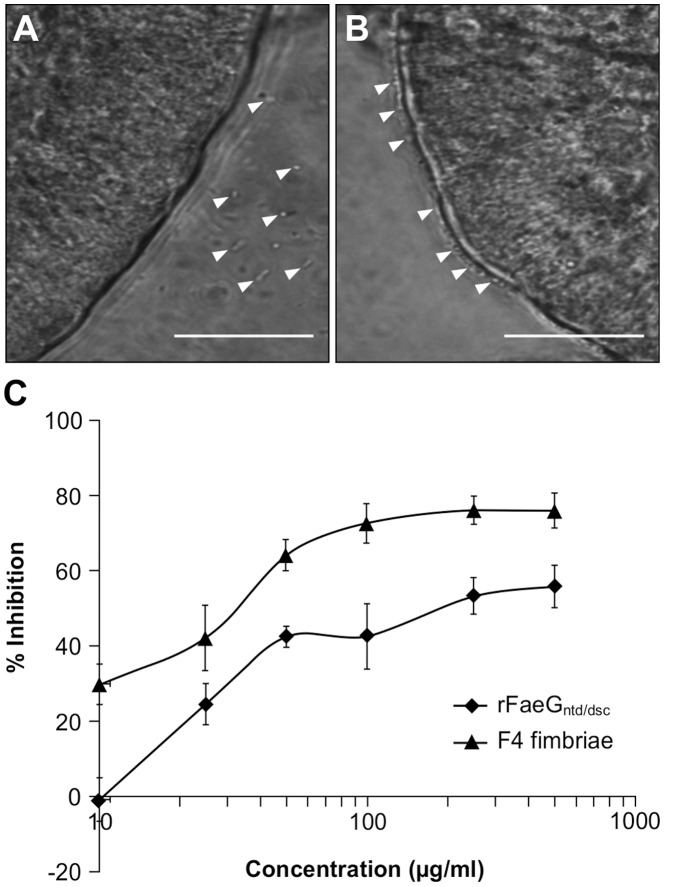
Chloroplast-produced rFaeGntd/dsc inhibits the adhesion of F4+ ETEC to porcine small intestinal villi.Adhesion of F4+ ETEC to F4R− villi (a) and F4R+ villi (b), white arrows indicate bacterial cells. Bar: 50 µm. (c) Competitive inhibition of adhesion of F4+ ETEC to porcine small intestinal villi by the rFaeGntd/dsc protein or F4 fimbriae, determined at different protein concentrations. The data represent the mean ±SE (n = 4).